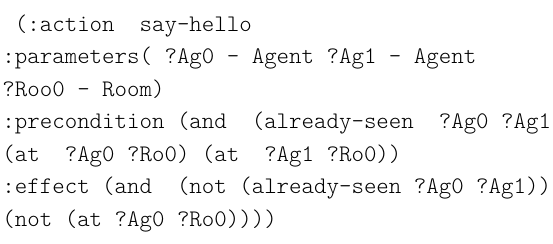
Figure 6: Snapshot of PDDL representation of the learnt action say- Hello